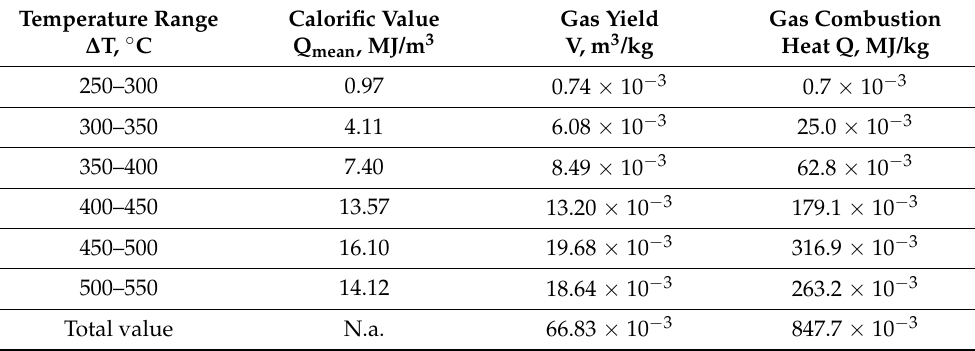
Table 3. The volumes and combustion heat of the pyrolysis gas combustible components relative to the Siberian pine nutshell